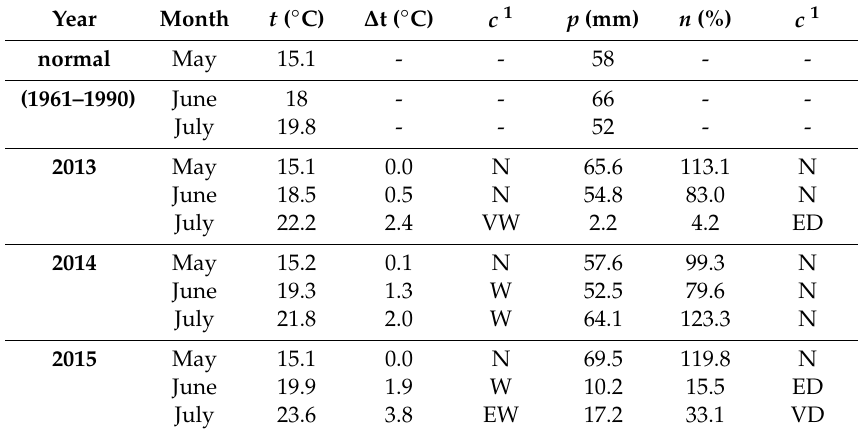
Table 1. Precipitation ( p ) and average temperature ( t ) during cultivation period with calculations of temperature di ff erence ( ∆ t) and a log-term normal ( n ), and indication of characteristic ( c ) [33].